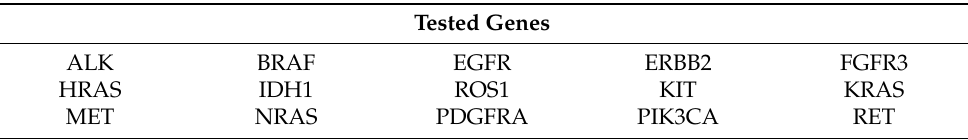
Table 1. Genetic panel used for all three patients.